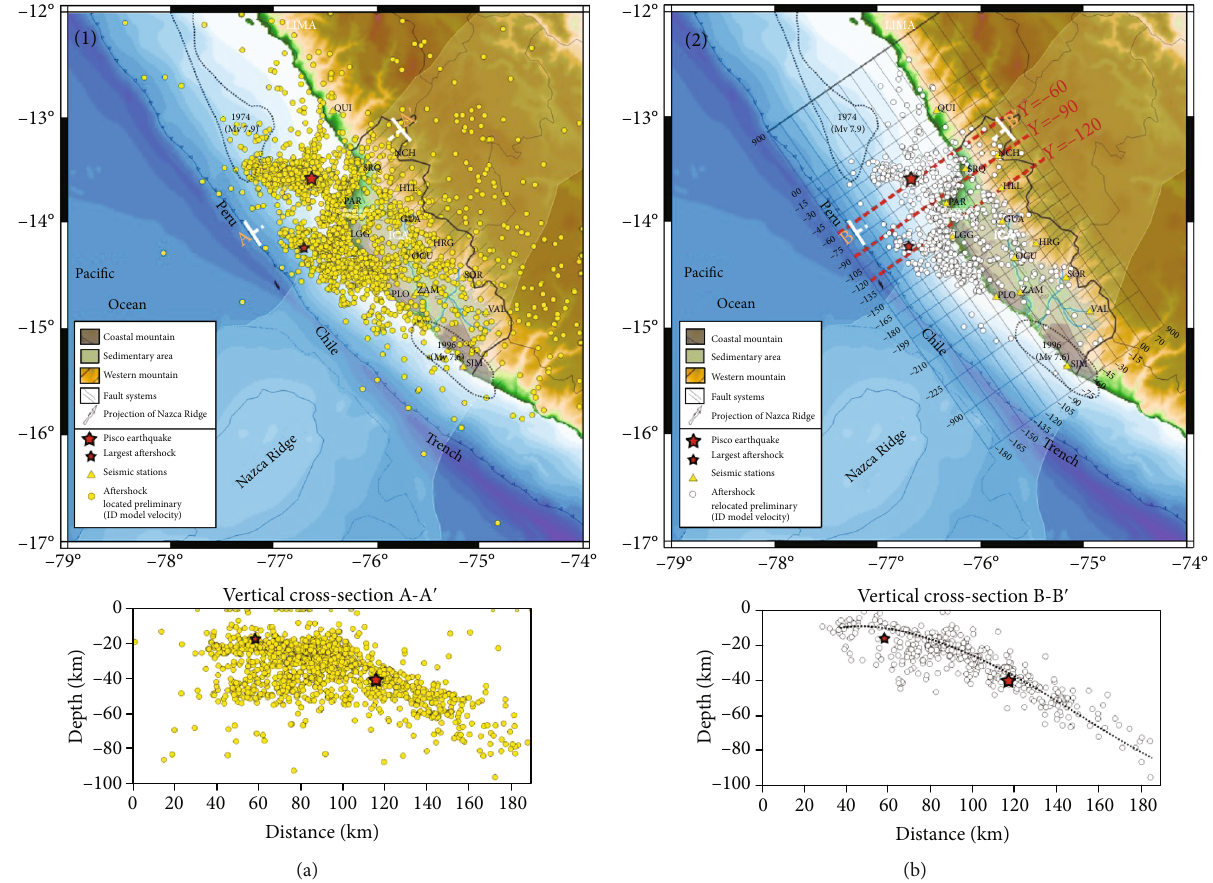
Figure 2: Aftershock distribution map for the Pisco earthquake registered from December 2007 to May 2008. The large red star corresponds to the main event epicenter, whereas the small star corresponds to the large aftershock. (a) Preliminary aftershock distribution map using the 1D velocity model [12] and its respective seismic pro fi le A-A ’ . (b) Relocated aftershock distribution map using the 3D velocity model (TomoDD), and its respective seismic pro fi le B-B ’ . The map presents the 15 km grid that was used on the inversion process to obtain the 3D velocity model and aftershock